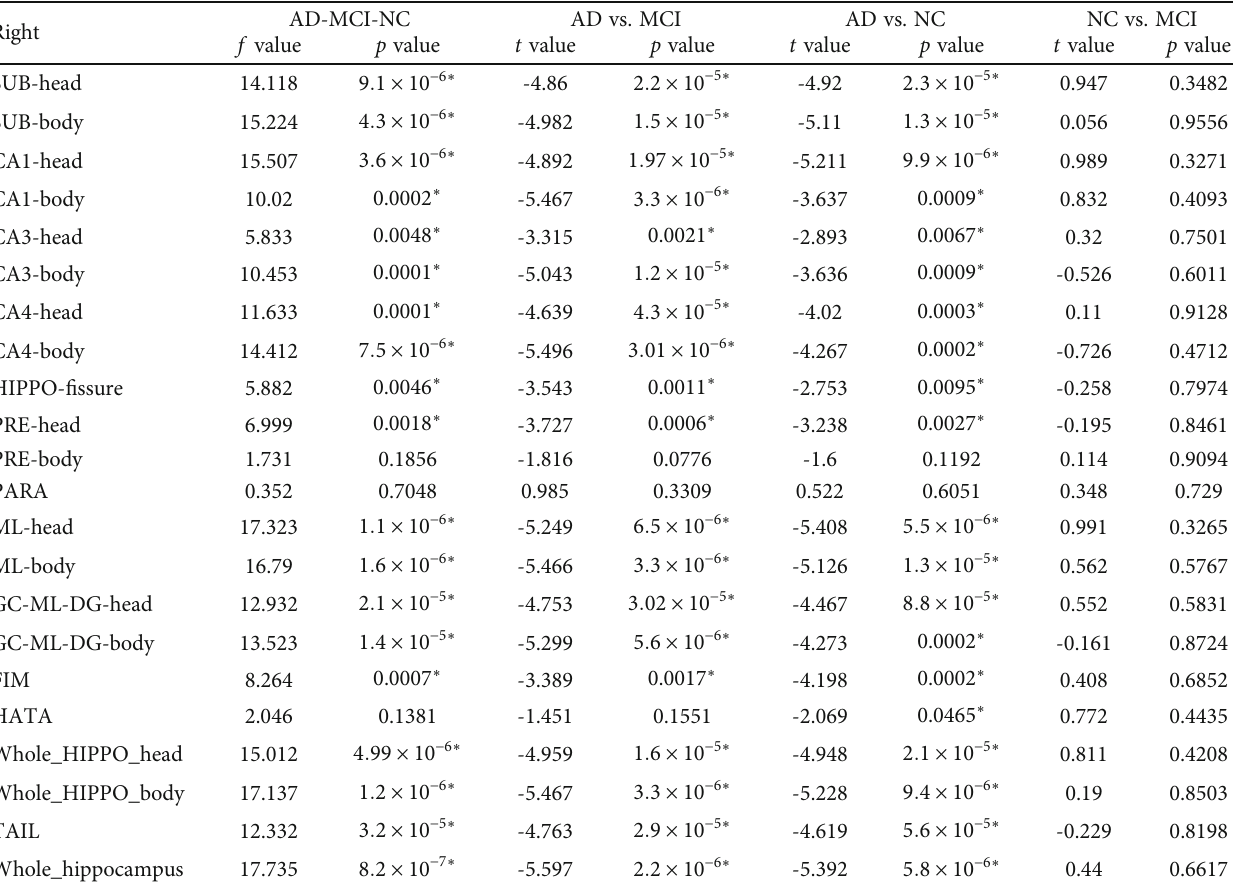
Table 5: ANOVA test and multiple comparison results of the subregion volumes of the right hippocampus between the three groups. Right